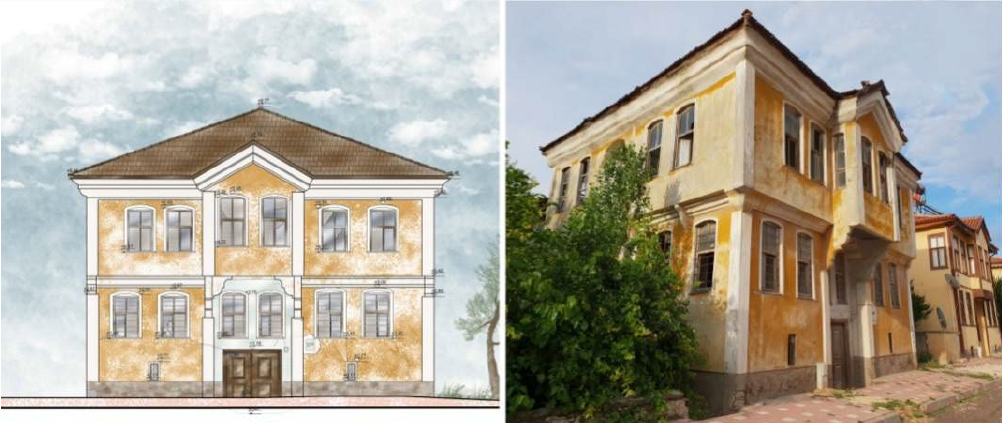
Figure 9 Kadıoğlu Pavilion survey drawing and 2019 photo